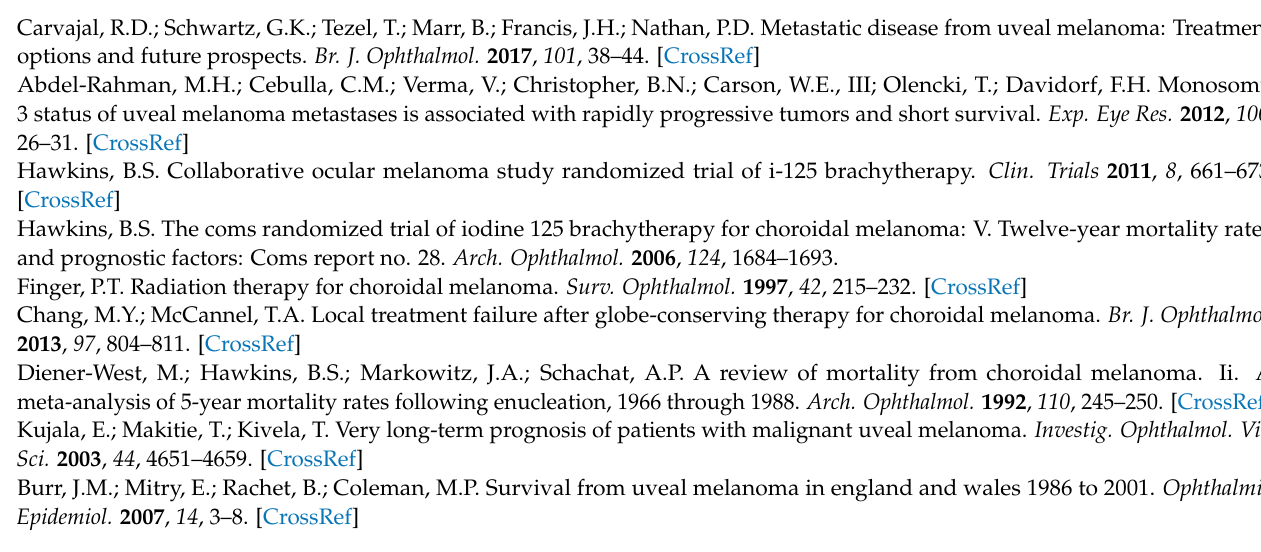
Figure S3: Kaplan-Meier survival curve and table where 386 UM patients who never demonstrated metastases were stratified according to the modality of scan performed; Figure S4: Kaplan Meier estimates for all 150 metastatic UM patients from primary treatment to detection of metastases, and from metastatic disease to death; Figure S5: Kaplan-Meier estimates for all 150 metastatic UM patients stratified according to type of treatment post detection of metastases; Figure S6: Kaplan- Meier survival curve and table for all metastatic UM stratified according to the type of treatment post detection of metastases; Table S1: Summary of studies reporting outcome of UM metastatic